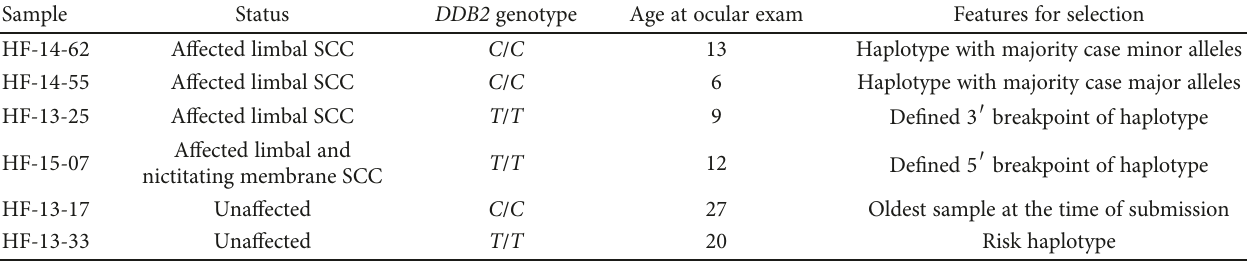
Table 1: Ha fl inger samples selected for whole genome sequencing based on phenotype, age, DDB2 c.1013 C > T genotype, and ECA12 haplotype analysis.